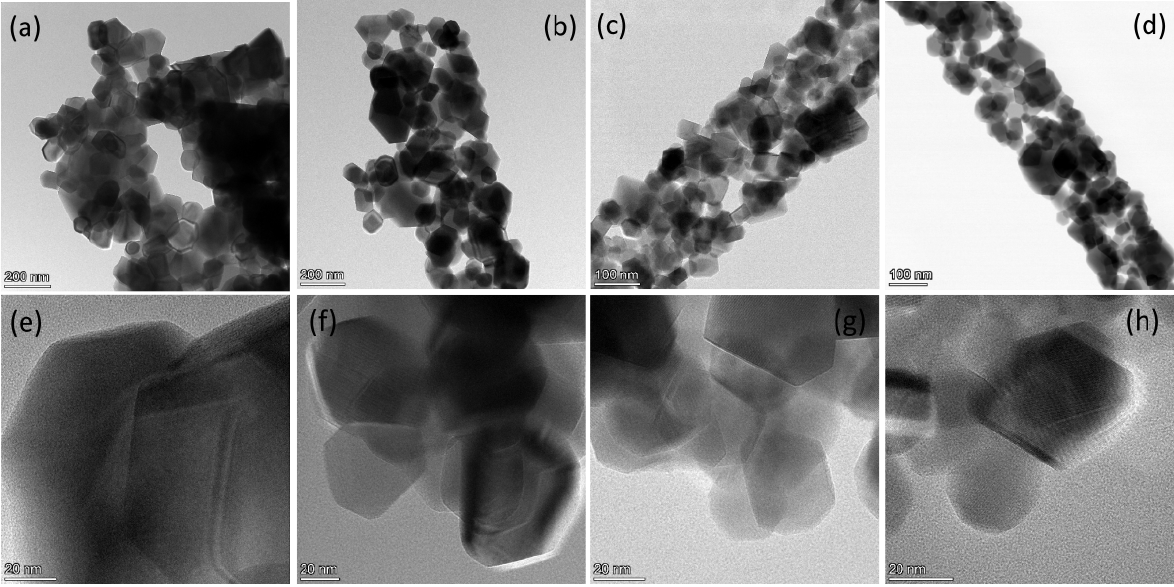
Figure 2. HRTEM images of samples ( a , e ) 5MF-sg, ( b , f ) 5ME-b, ( c , g ) 5MF-b and ( d , h ) 5MG-b.